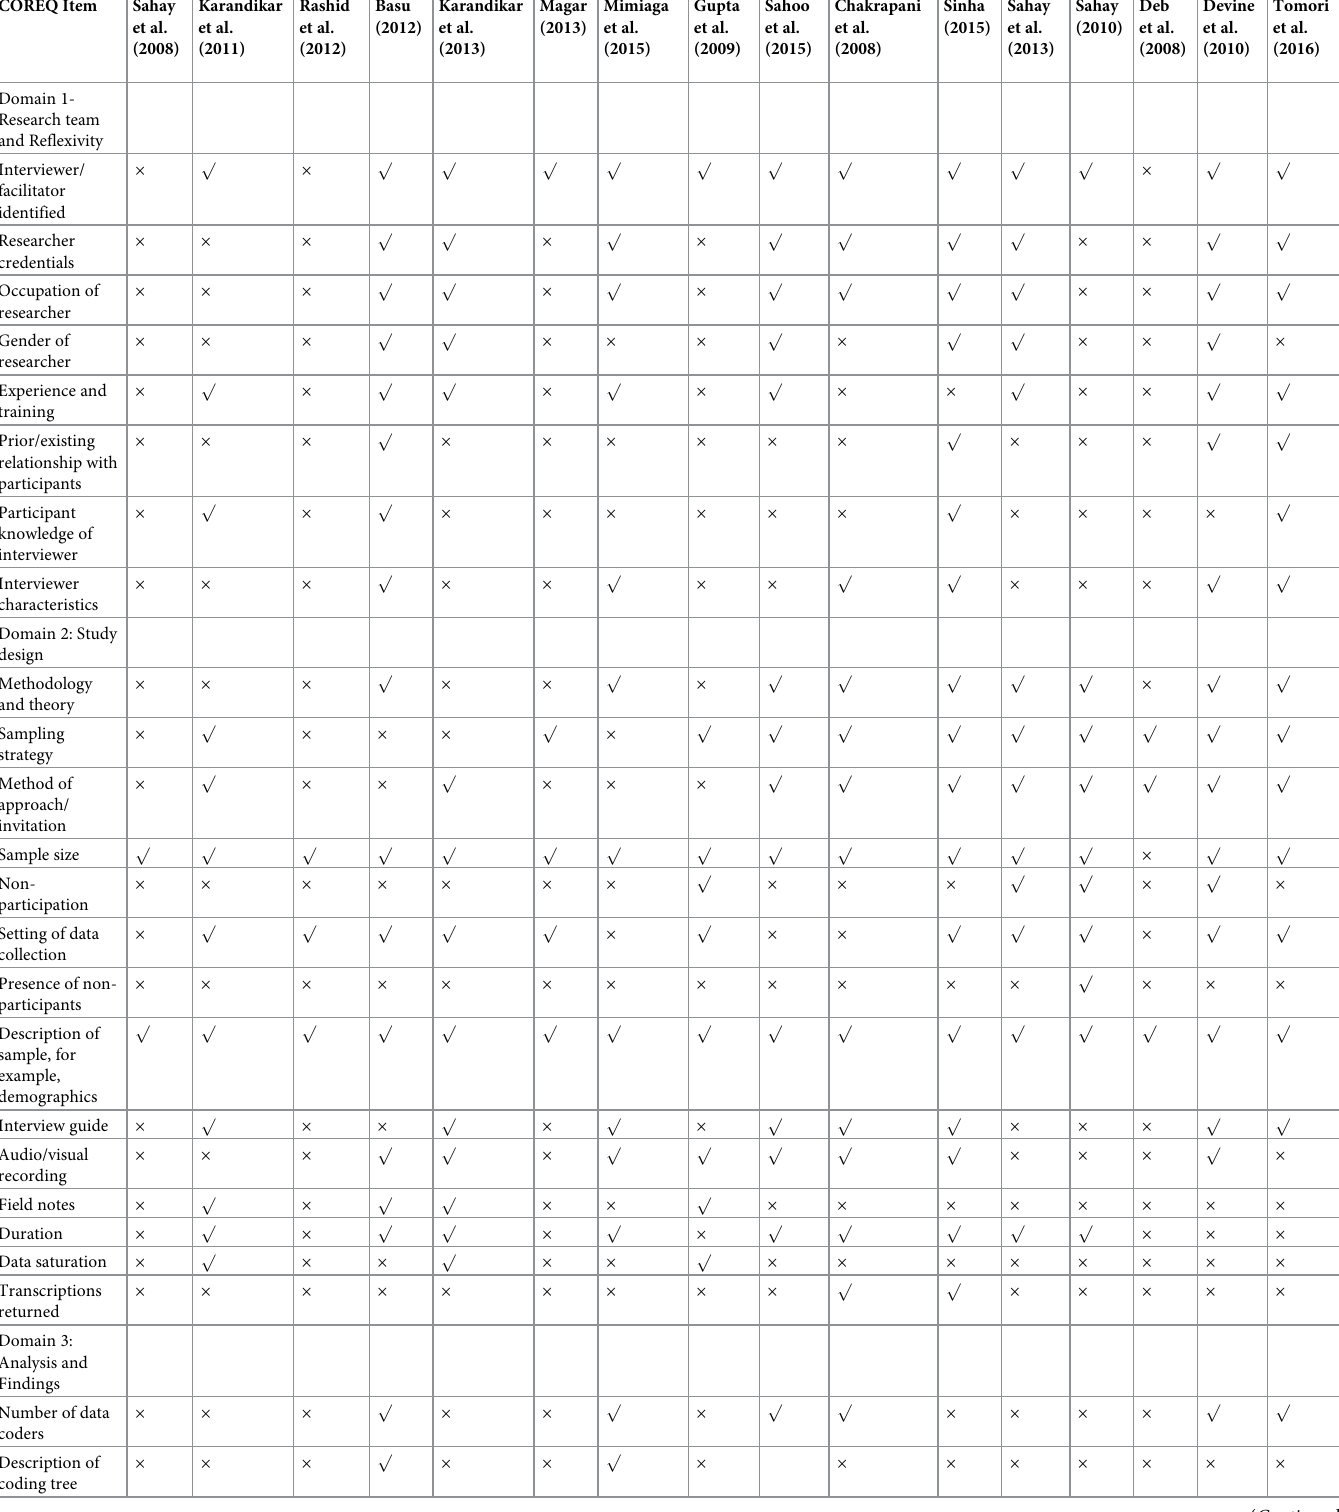
Table 14. Comprehensiveness of reporting of qualitative and mixed-methods studies. COREQ